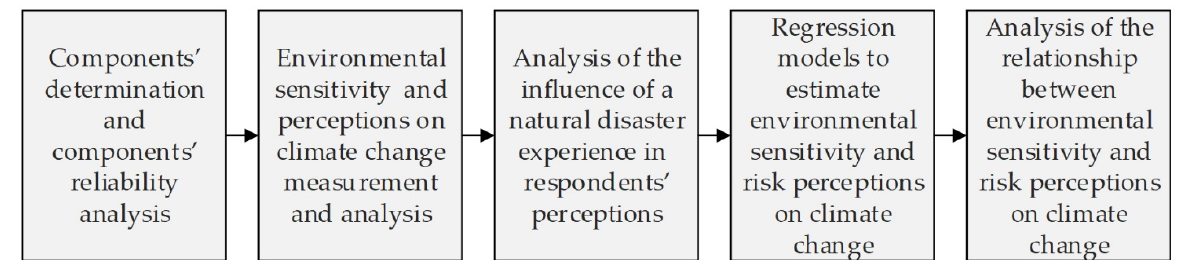
Figure 2. Basic steps of the analysis.